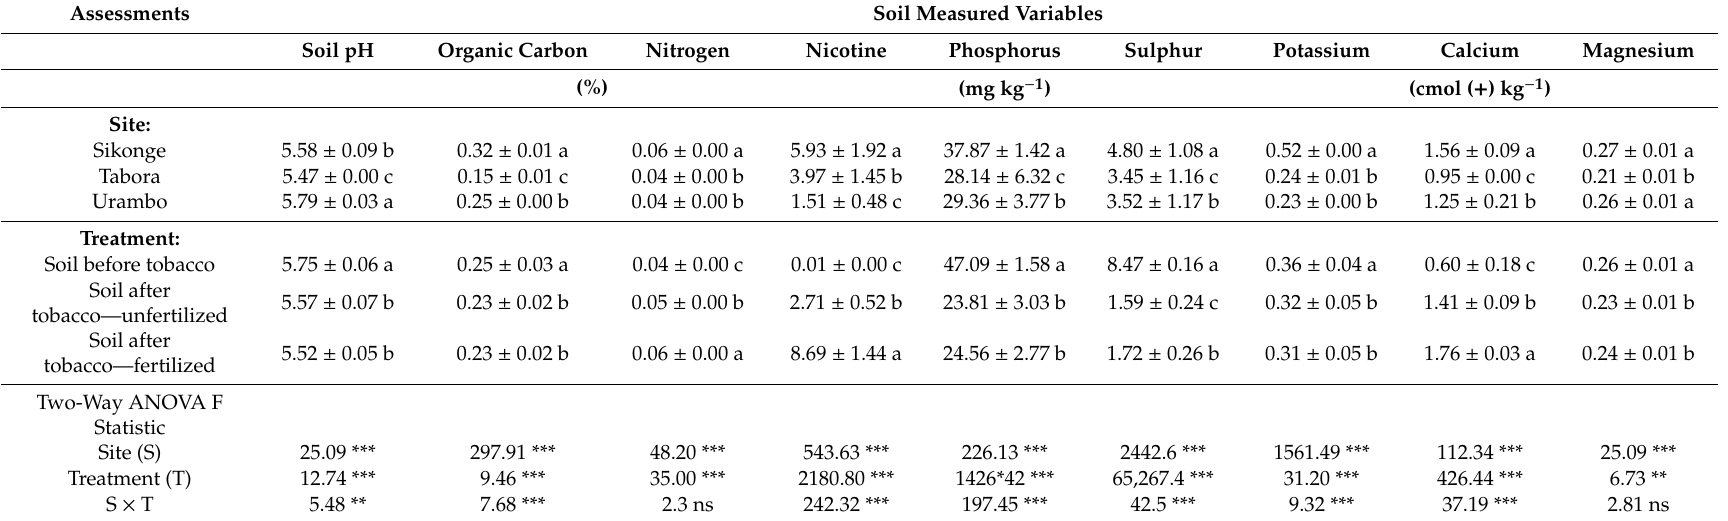
Table 2. Selected soil properties of Sikonge, Tabora, and Urambo experimental sites before and after experiments.